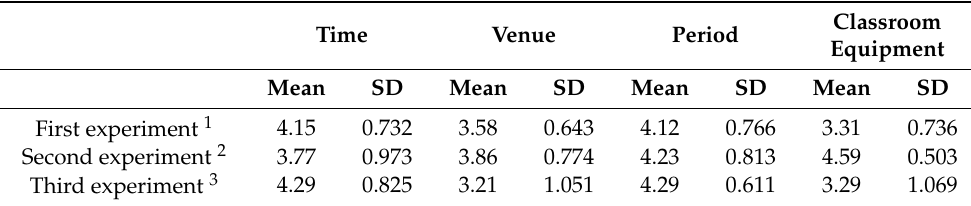
Table 10. Mean values and standard deviations of “spatial technical/logistical infrastructure” ques- tions in relation to the experiments (level of study/place of conduct of the interactive teaching) of budding